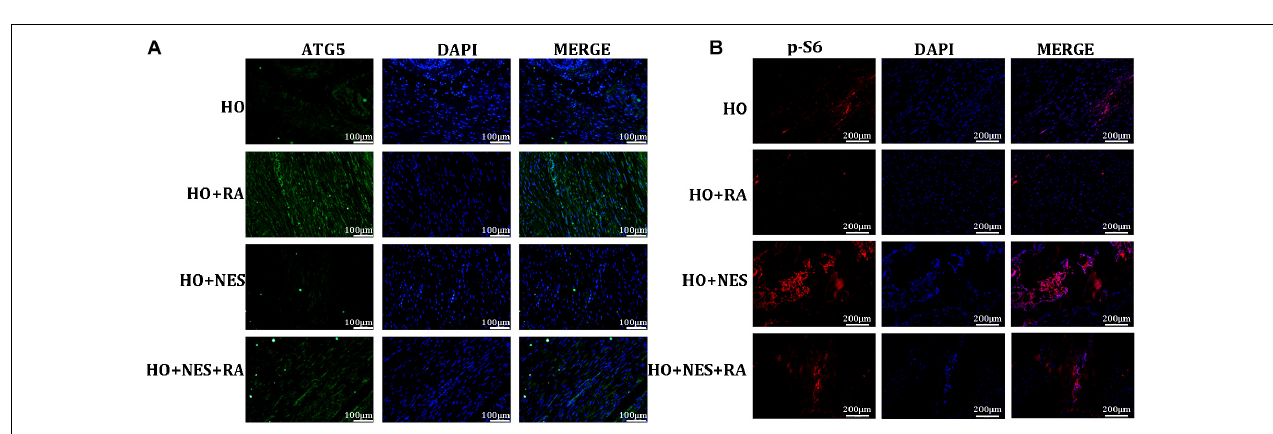
FIGURE 8 | Nesfatin-1 promotes activation of the mTOR pathway in vivo . (A) The expression of ATG5 was evaluated as an indicator of autophagy by immunofluorescence, Scale bar, 100 µ m. (B) p-S6 protein in the tissue sections was evaluated as an indicator of mTOR signaling by immunofluorescence, Scale bar, 200 µ m. The values are expressed as the mean ± standard deviation (SD). * p < 0.05, ** p < 0.01 vs. the control group.